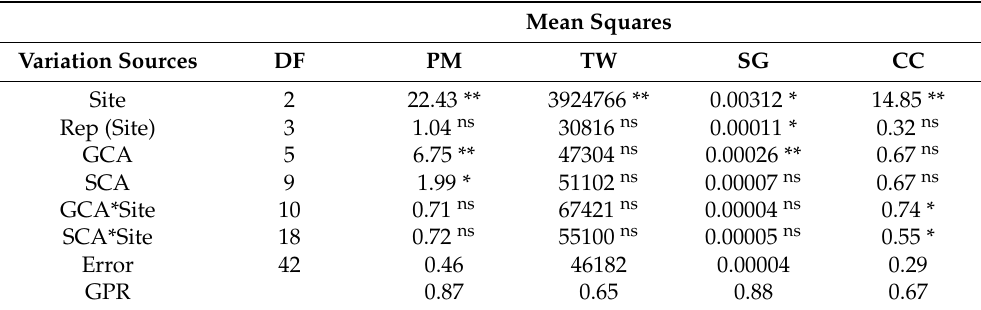
Table 7. Mean squares and significant tests of general combining abilities (GCAs) and specific combining abilities (SCAs) for agronomic and quality traits across three environments. Mean Squares Variation